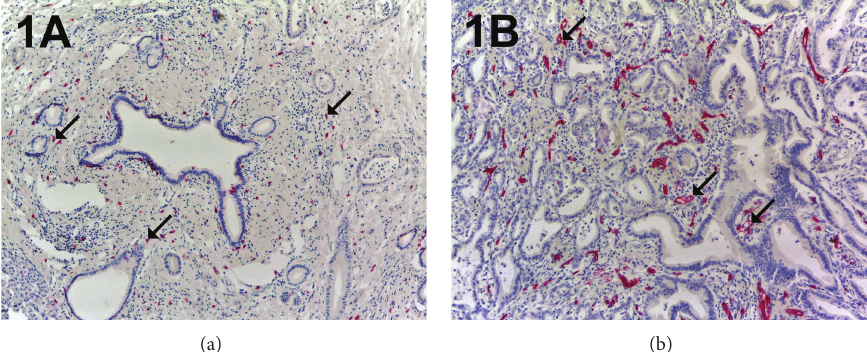
Figure 1: In (a) a pancreatic ductal adenocarcinoma sample stained with the anti-tryptase antibody. Many scattered red immunostained MCs. Arrows indicate single MC. Magnification: in (b) a highly vascularized pancreatic ductal adenocarcinoma sample stained with the anti-CD-31 antibody. Many red immunostained microvessels. Arrows indicate microvessel. Magnification: (a-b), × 100.